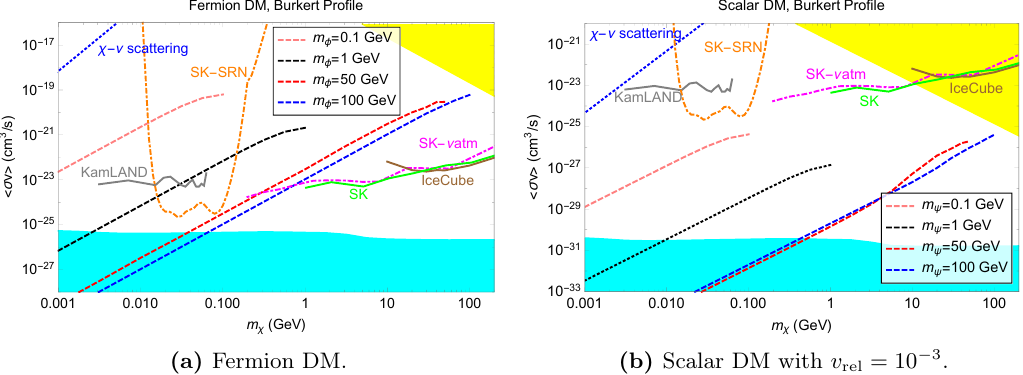
Figure 10. The 90% CL bounds from various neutrino telescope observations compared with the collider bounds. The gray line, labelled KamLAND, is the (rescaled) o(cid:14)cial KamLAND bound [69]. The green line, labelled SK, is the (rescaled) o(cid:14)cial SK bound [68]. The brown line, labelled IceCube, is the o(cid:14)cial IceCube bound [67]. The orange, dot-dashed line, labelled SK-SRN, is the bound obtained from recasting the SK SRN searches discussed in section 4.1. The magenta, dot- dashed line, labelled SK- (cid:23) atm, is the bound obtained from recasting the SK atmospheric neutrino measurements discussed in section 4.2. The shaded yellow region is excluded by perturbativity constraint on the DM-neutrino coupling, y , and the constraint m (cid:31) m (cid:30) ( ) . The shaded cyan (cid:20) region is the region that gives (cid:10) (cid:31) h 2 > 0 : 1186 simulated using Micromegas 5.0 [80]. The blue dotted lines are the cosmological bounds from the DM-neutrino scattering discussed in section 2.2. For